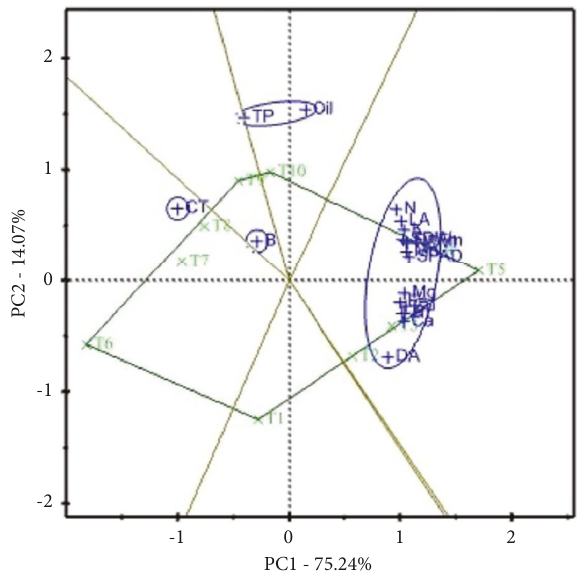
Figure 3: A principal component analysis (PCA) biplot for the first two principal component (PC) scores, PC1 vs. PC2, related to the classification of 19 variables of clary plants measured under irri- gation treatments. Treatments are in green colour, and traits are in blue colour. T1, 100% ETo without nitrogen-fixing bacteria; T2, 100% ETo+B subtilis; T3, 100% ETo+ Ps. flu ; T4, 100% ETo+ Cyanobacteria ; T5, 100% ETo+ Trichoderma ; T6, 50% ETo without nitrogen-fixing bacteria; T7, 50% ETo+B . subtilis ; T8, 50% ETo+